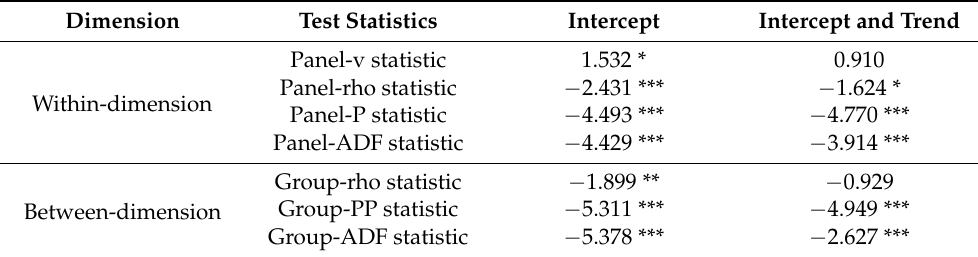
Table 5. Pedroni panel cointegration test